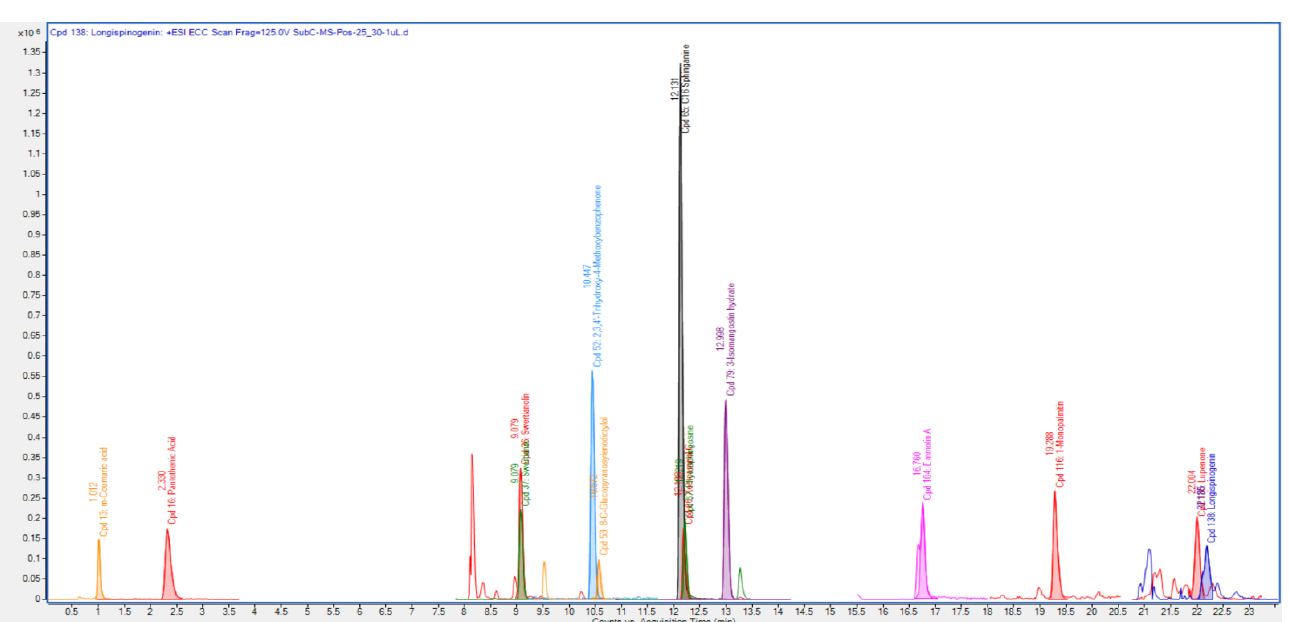
Table 2. α -glucosidase inhibition activity of extracts obtained from different extraction techniques.